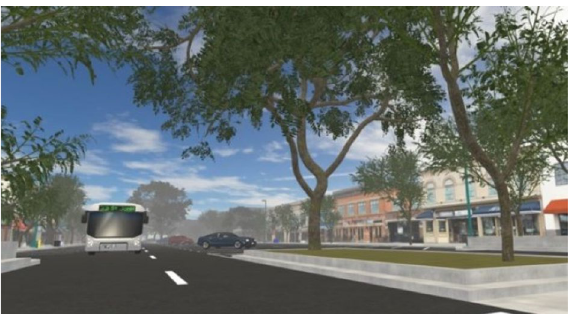
Figure 2. Example scene from modifiable VR environment used in pilot